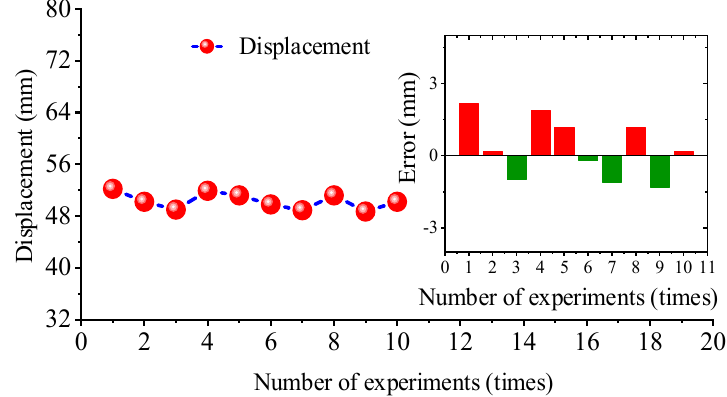
Figure 29. Displacement data of hydraulic support base.